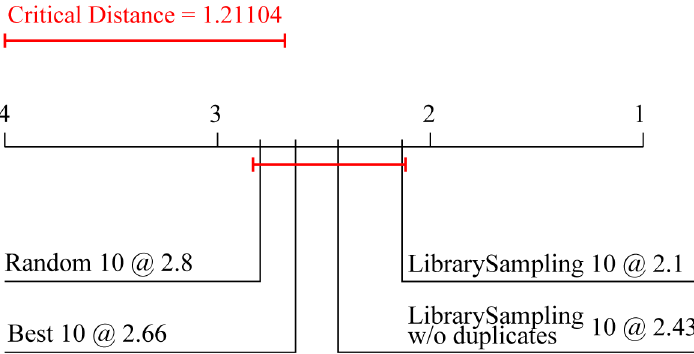
Fig 6. Comparison of the average ranks for predictive performance of the two library sampling methods to two alternative ensemble approaches. Average ranks of four different types of ensembles with 10 constituents combined by averaging. The constituents are: constructed via library sampling with and without duplicates, the 10 best models learned from the complete library, and 10 random models learned from the complete library. The average ranks of predictive performance are computed over the 15 data sets.